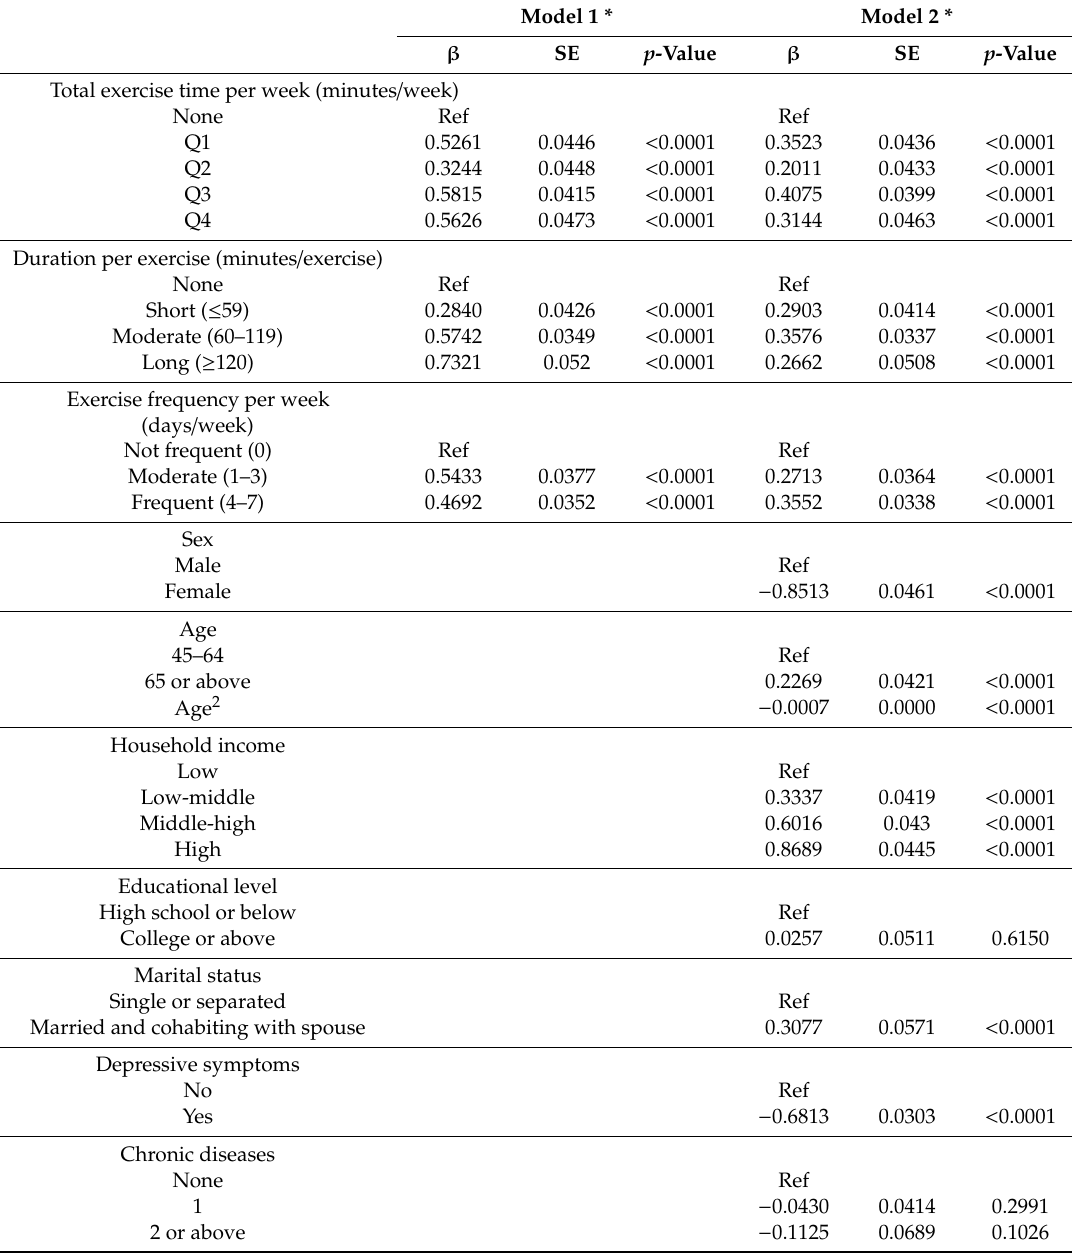
Table 3. The association between MMSE scores and physical